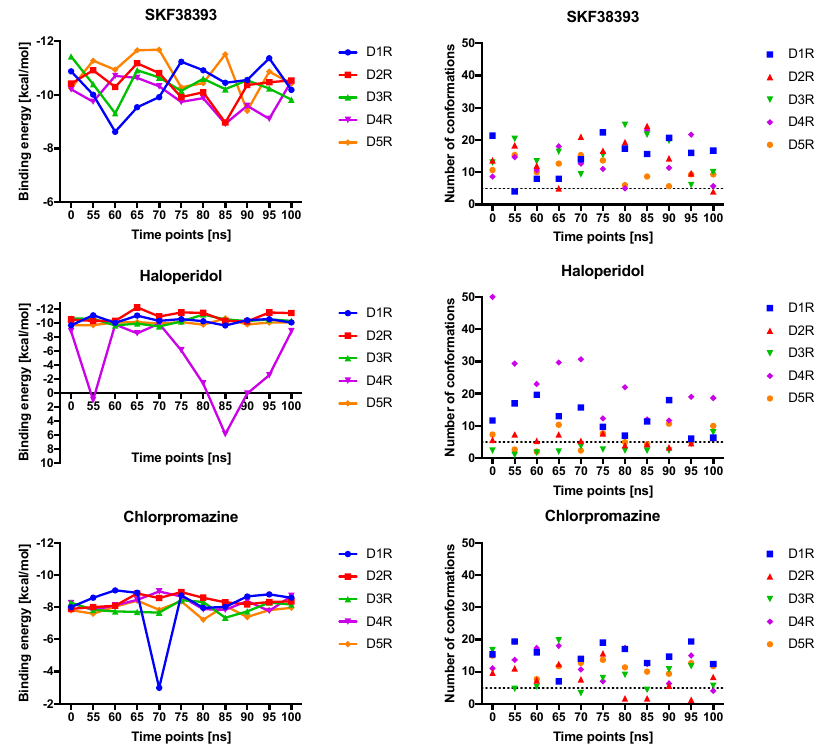
Figure 4. Results of the molecular docking of 7-OH-DPAT, apomorphine, nemonapride, SCH23390, SKF38393, haloperidole and chlorpromazine for all DR subtypes at time points [ns]. The average of the three lowest binding energies of dopamine were calculated in the left plots. The mean of the number of conformations of the three clusters with the lowest binding energies were plotted for each time point and receptor (right plot).